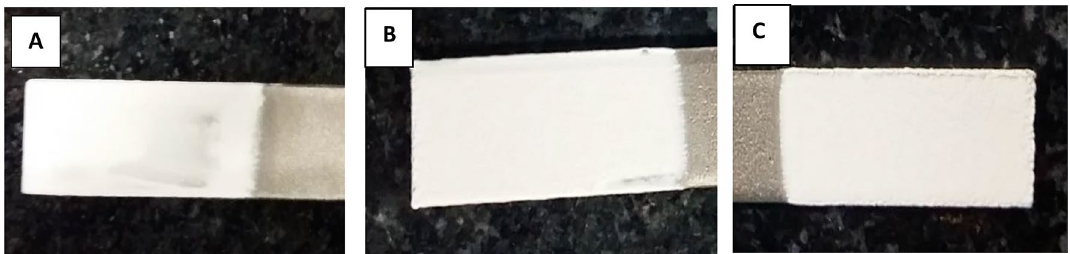
Fig. 7 Images of the coating in A : 30, B : 60, and C : 90 V deposited in the optimum time of 10 min